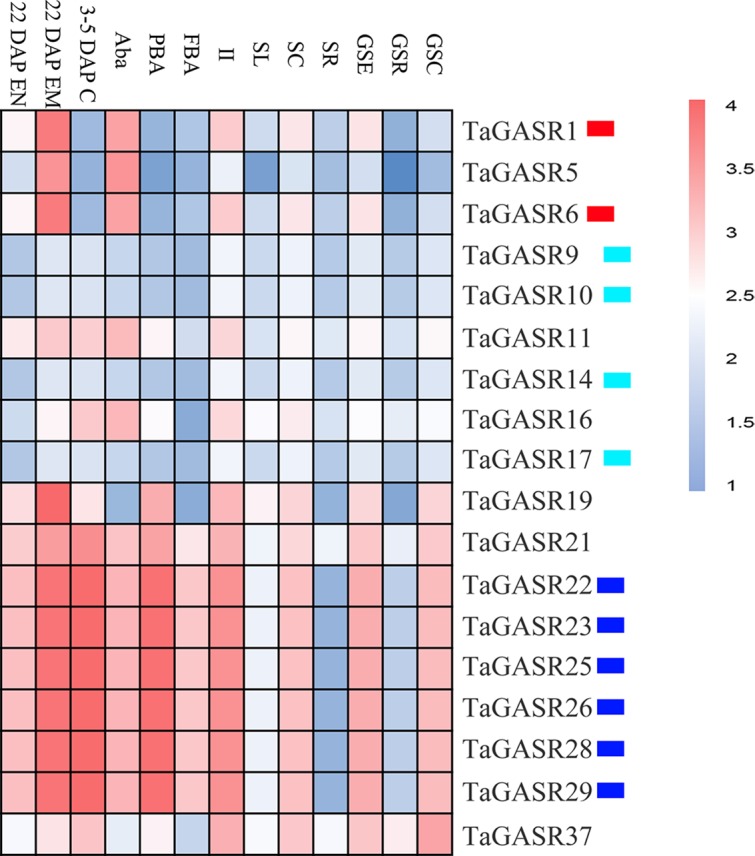
Expression profiles of TaGASR genes in different tissues and at different developmental stages. Heatmap shows hierarchical clustering of the 18 TaGASR genes among different tissues. Abbreviations represent specific developmental stages: GSC, germinating seed, coleoptile; GSR, germinating seed, root; GSE, germinating seed, embryo; SR, seedling, root; SC, seedling, crown; SL, seedling, leaf; II, immature inflorescence; FBA, floral bracts, before anthesis; PBA, pistil, before anthesis; Aba, anthers, before anthesis; 3–5 DAP C, 3–5 DAP caryopsis; 22 DAP EM , 22 DAP embryo; 22 DAP EN, 22 DAP endosperm.